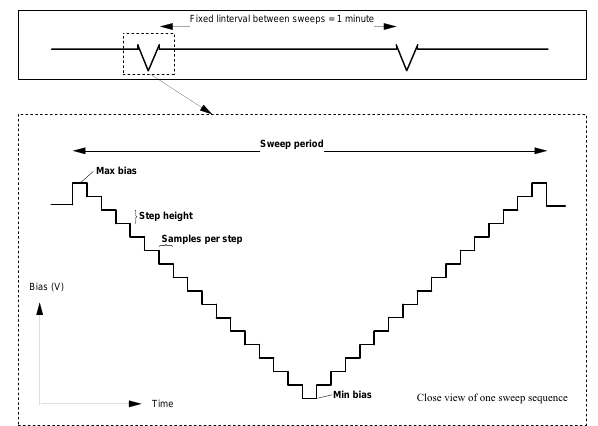
Fig. 8. A graphical representation of a 32-step bias sweep se- quence showing the different parameters that were set by ground commands. Normal-Burst mode sweep shown (1 minute